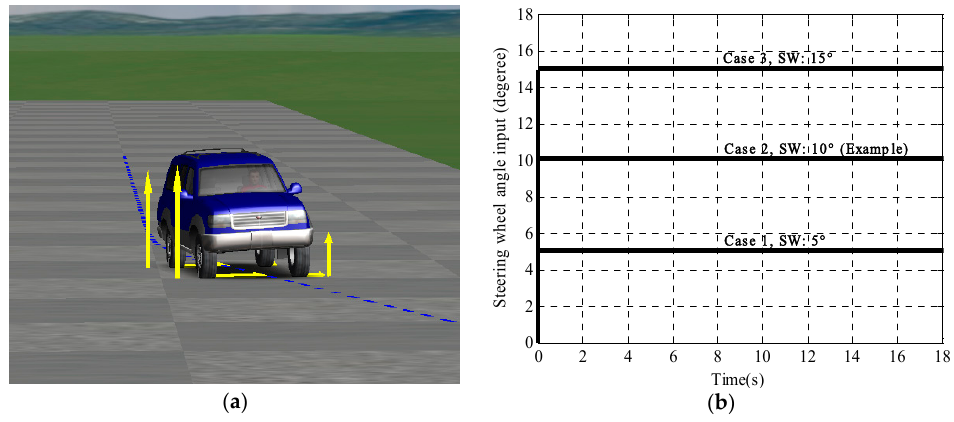
Figure 8. CARSIM simulation of roll behavior under various road excitation conditions. ( a ) Animation Screen. ( b ) Steering wheel input.